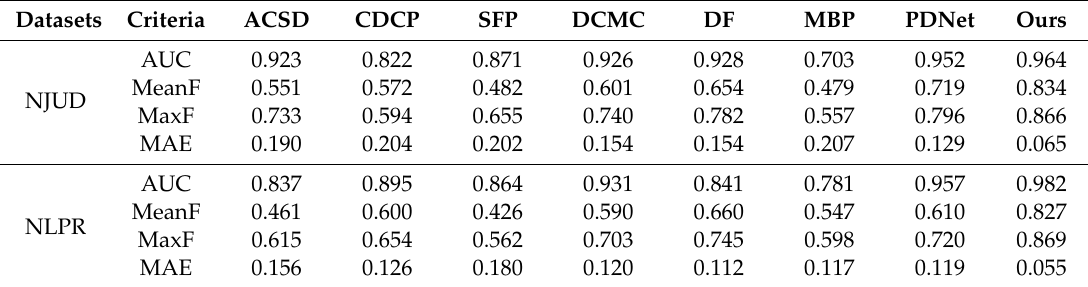
Table 1. Saliency Detection Performance of Di ff erent Methods on the Testing set of the NJUD and NLPR